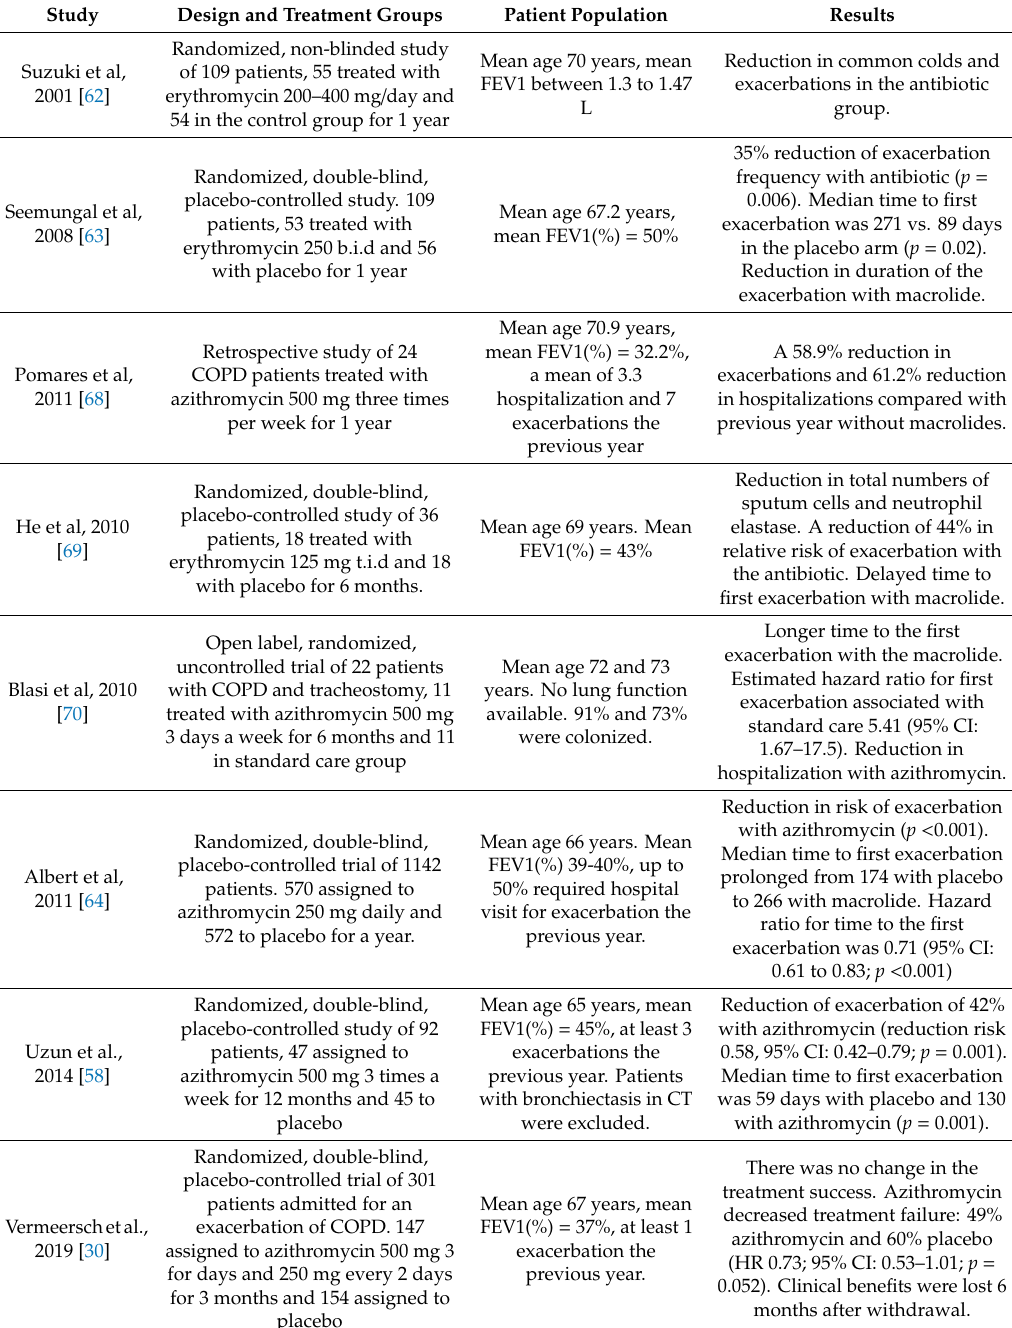
Table 3. Clinical trials of long-term macrolide treatment for